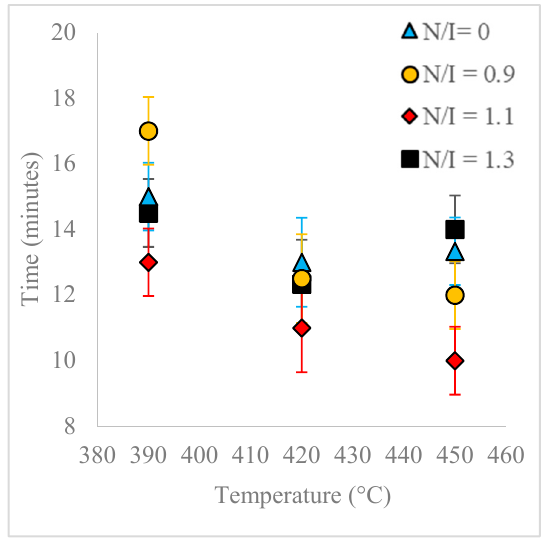
Figure 6. Reaction time (min) vs. temperature (C).